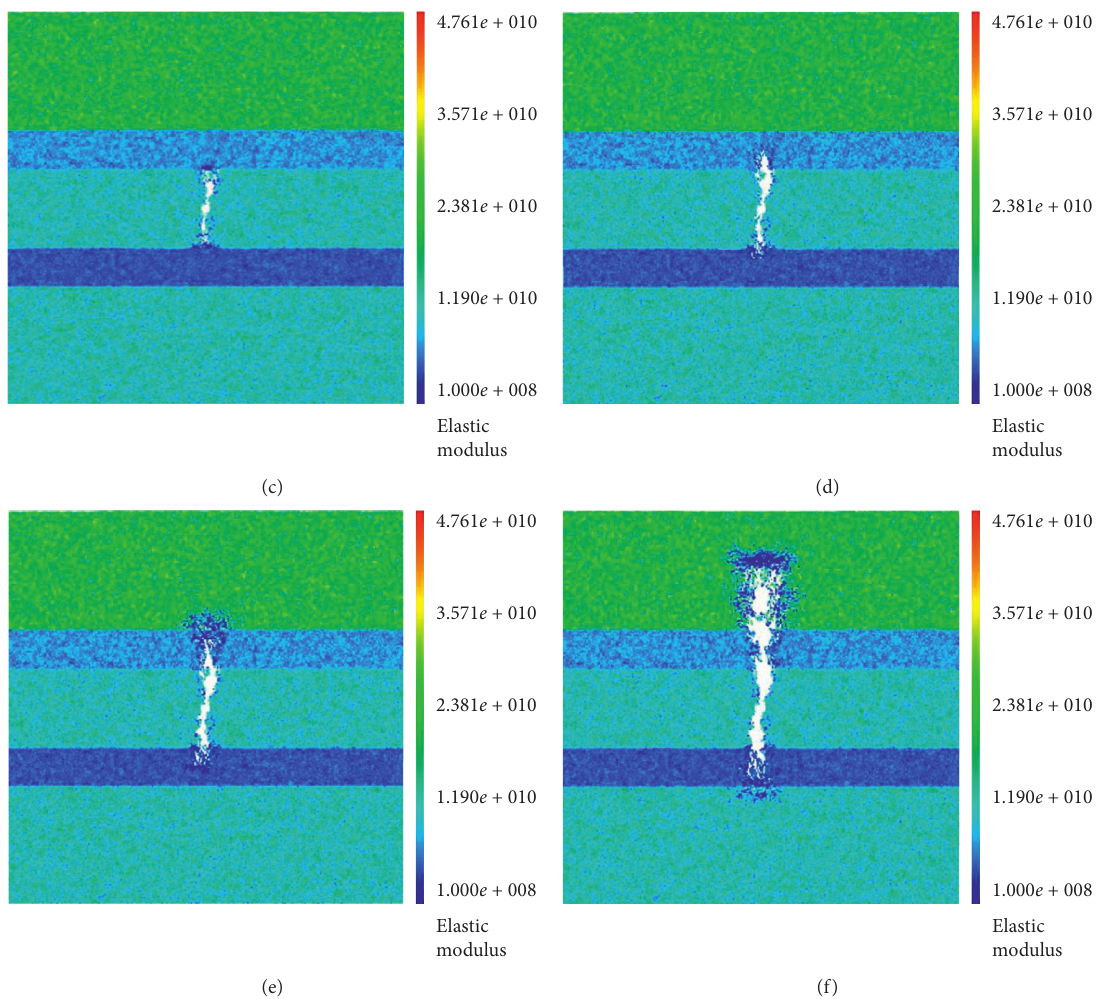
Figure 5: Elasticity modulus evolution of numerical model No. 2. (a) Step 29-1. (b) Step 33-7. (c) Step 33-8. (d) Step 33-12. (e) Step 33-15. (f) Step